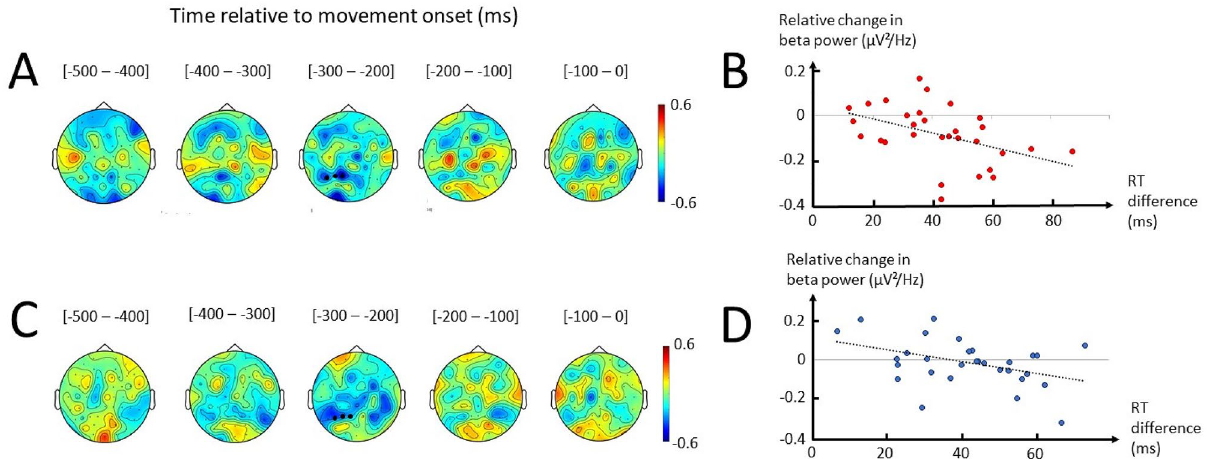
Figure 6. Correlations between beta power and RT difference associated with Difficulty in Instructed and Free. ( A ) Topographical representation of Spearman’s coefficients of correlation between the difference in baseline- normalized beta power and RT in Instructed as a function of Difficulty (Instructed Hard–Instructed Easy) performed on each electrode separately. Each topographical plot represents the average Spearman’s coefficient in 100-ms windows defined according to movement onset. Black dots indicate the electrodes with the highest absolute coefficient, specifically represented in B . ( B ) Linear fit between the difference in baseline-normalized beta power at left parietal electrodes (P1, P3, P5) and the difference in RT in Instructed as a function of Difficulty. ( C ) Topographical representation of Spearman’s coefficients of correlation between the difference in baseline-normalized beta power and RT in Free as a function of Difficulty (Free Hard–Free Easy) performed on each electrode separately. Black dots indicate the electrodes with the highest absolute coefficient, specifically represented in D . ( D ) Linear fit between the difference in baseline-normalized beta power at left parietal electrodes (P1, P3, P5) and the difference in RT in Free as a function of